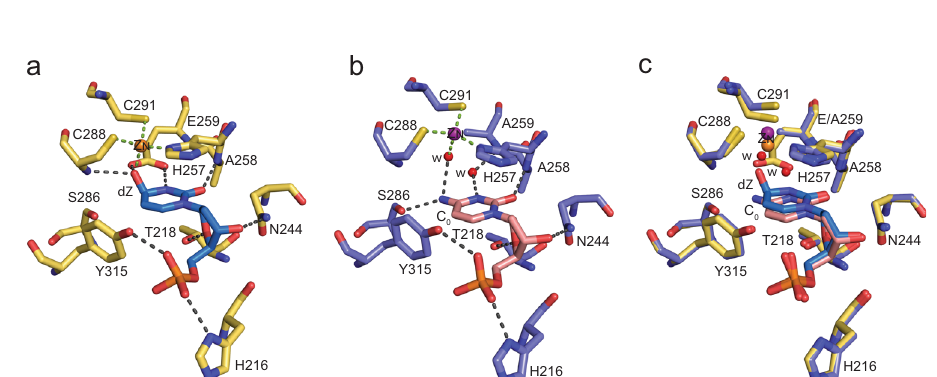
Fig. 3 | Visualizationofthe targetnucleotidein the active site and comparison with substrate (2 ′ -deoxy-cytidine) bound to inactive enzyme. The green and gray dotted lines indicate Zn 2+ coordination and hydrogen bonds, respectively. a ActivesiteinteractionsofactiveA3G-CTD2withthe2 ′ -deoxy-zebularinehydrated intermediate(dZ-H 2 O)(PDB7UXD).Zn 2+ isshownasanorangesphere.C,N,SandO atoms are colored yellow, navy blue, golden-yellow, and red, respectively, for amino acid residues of the protein. Atoms in nucleotides are colored blue, navy blue, red, and orange for C, N, O, and P, respectively. b Active site interactions of possible, the 2 ′ -deoxy-zebularine nucleobase and Zn-coordinating residues adjust their positions accordingly. The pyrimidine ring of the hydrated 2 ′ -deoxy zebularine (dZ-H 2 O) tilts upward ~8 o when com- pared to the target cytosine (C 0 ) in our previous A3G-CTD2*:ssDNA structure. This tilt increases the distance between equivalent nucleo- base atoms in the two structures gradually across the base from the anomeric C1 ′ (0.36Å) to the C4 atom (0.71 Å). In addition, the Zn 2+ ion ispulleddown~0.8 ÅfromtheinactiveA3G-CTD2*:ssDNAstructure.As a result, the Zn coordinating residues also shift down relative to the A3G-CTD2*:ssDNA structure, the SG atom of 288 C, SG atom of 291 C, and ND1 atom of 257H move down 0.34Å, 0.99Å and 0.31Å, respec- tively (Fig. 3c). Overall, in the active A3G-CTD2:dZ-ssDNA structurethe total Zn-O-C4 distance is 3.5Å compared to a Zn-water-C4 distance of